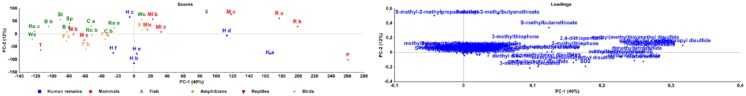
PCA plots of sulphur-containing compounds.Score- and loadingplot of sulphur-containing compounds after six months of decomposition.